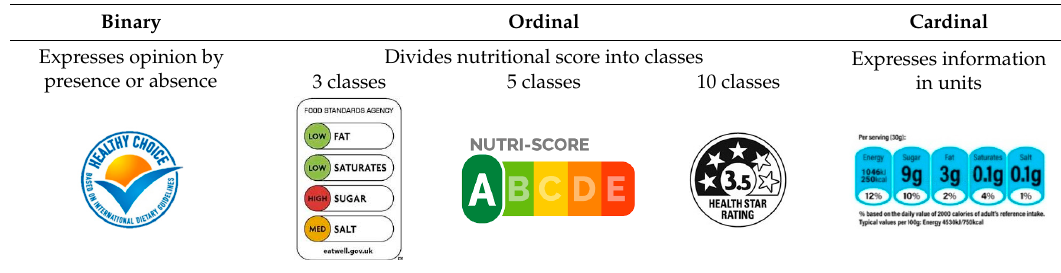
Table 3. Description and examples of FoPLs according to their Gradation. Binary Ordinal Cardinal Expresses opinion by Divides nutritional score into classes Expresses information presence or absence